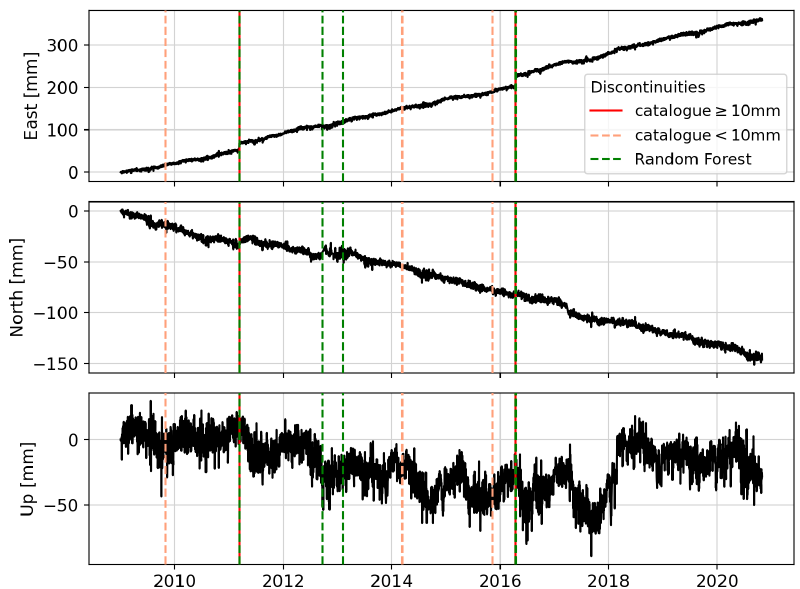
Figure 10. GPS station coordinate time series of the station G068 for the east, north and up component. The vertical light red and dark red lines mark potential earthquake discontinuities from the NGL discontinuity database, while the green lines mark discontinuities detected by Random